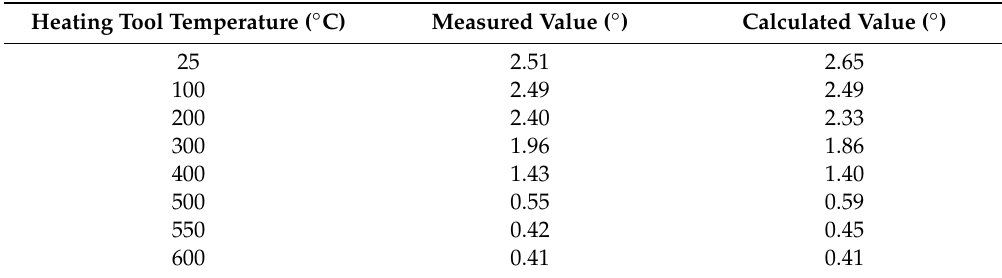
Table 2. The average springback angle under di ff erent heating tool